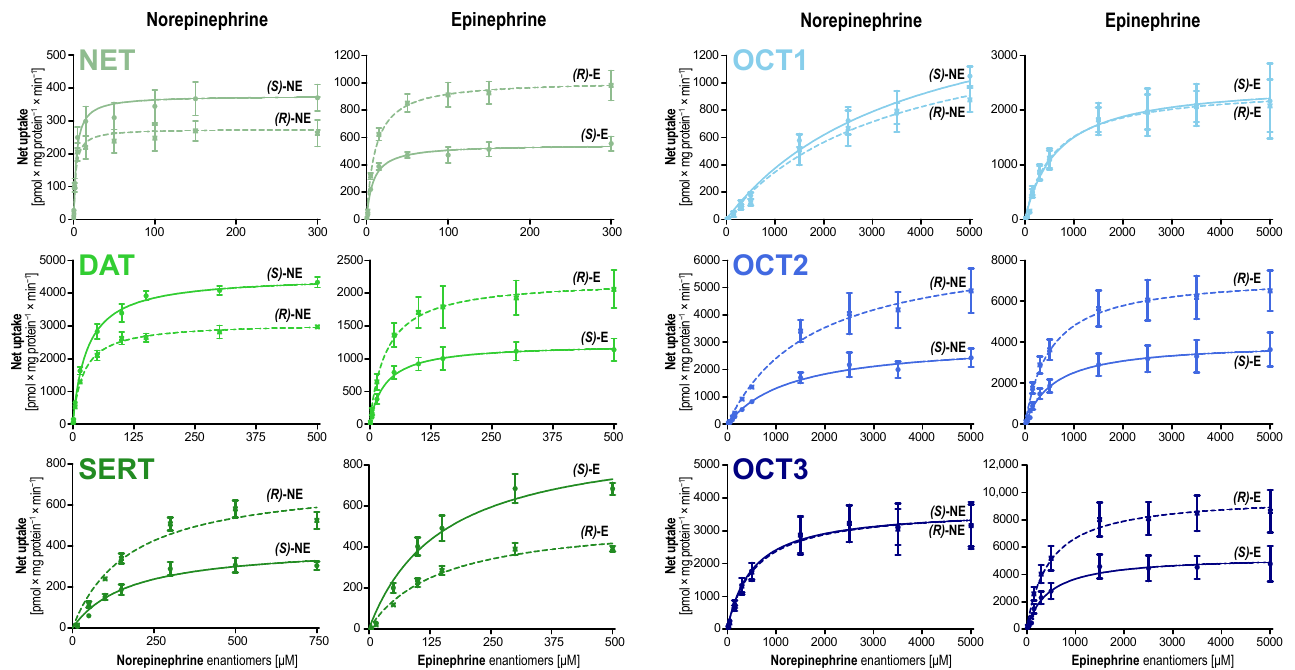
Figure 2. Stereoselective uptake of norepinephrine (NE) and epinephrine (E) by MATs and OCTs. Transporter-overexpressing HEK293 cells were incubated for two minutes with increasing concen- trations of racemic norepinephrine and epinephrine. Data are provided as mean ± SEM of three independent experiments. Note that different scaling had to be applied in the graphs, particularly due to the substantially higher affinity of NET in comparison to the other transporters.